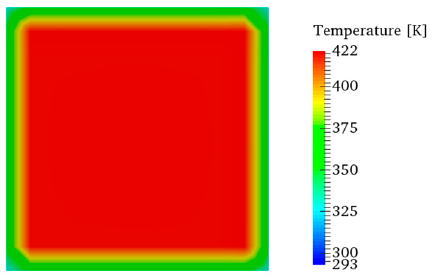
Figure 8. Distribution of FDTD-calculated temperature of the upper surface ( x-y plane) of the MOV at a time of 32 μ s for the injected current, shown in Figure 5. The initial temperature is set to 293 K.